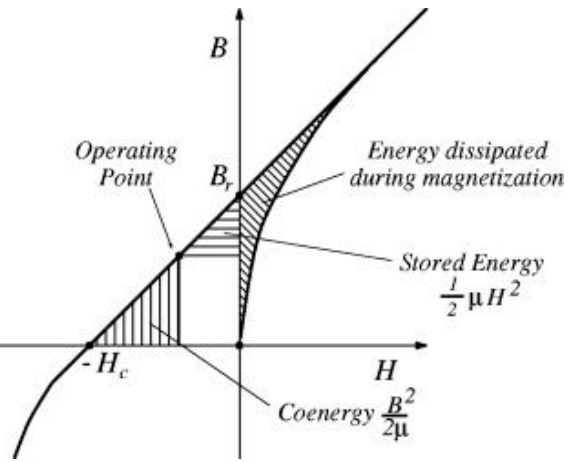
Figure 1. Energy stored in a permanent magnet [20]. B : magnetic field density, H : magnetic field intensity, B r : magnetic remanence; µ : permittivity; H c : magnetic coercivity.